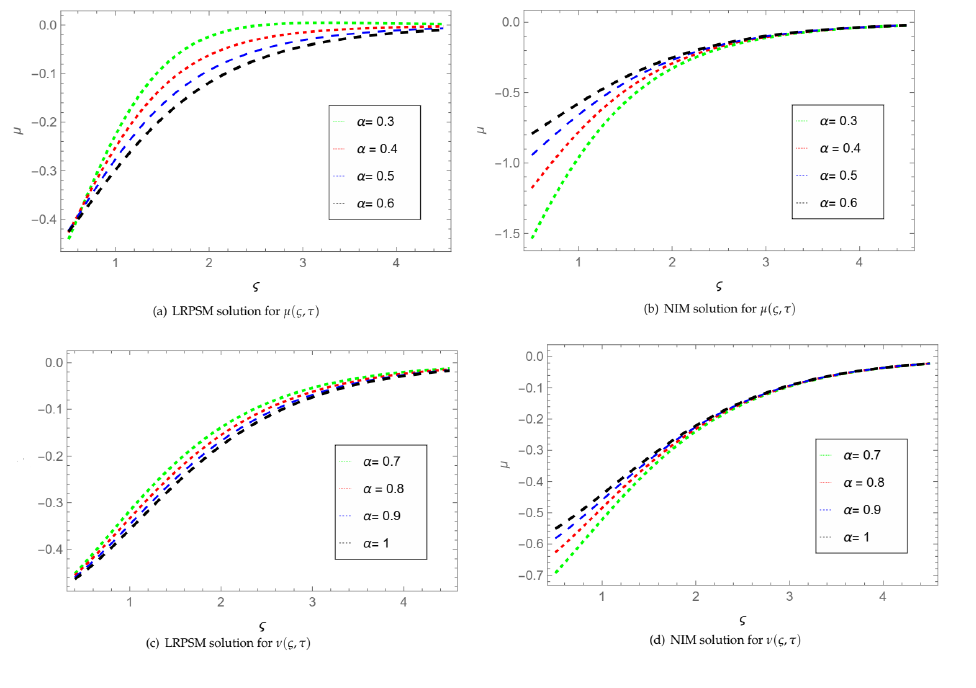
Figure 1. Two-dimensional plots of the LRPSM and NIM solutions for µ ( ς , τ ) and ν ( ς , τ ) at various value of fractional -order and τ = 0.1.